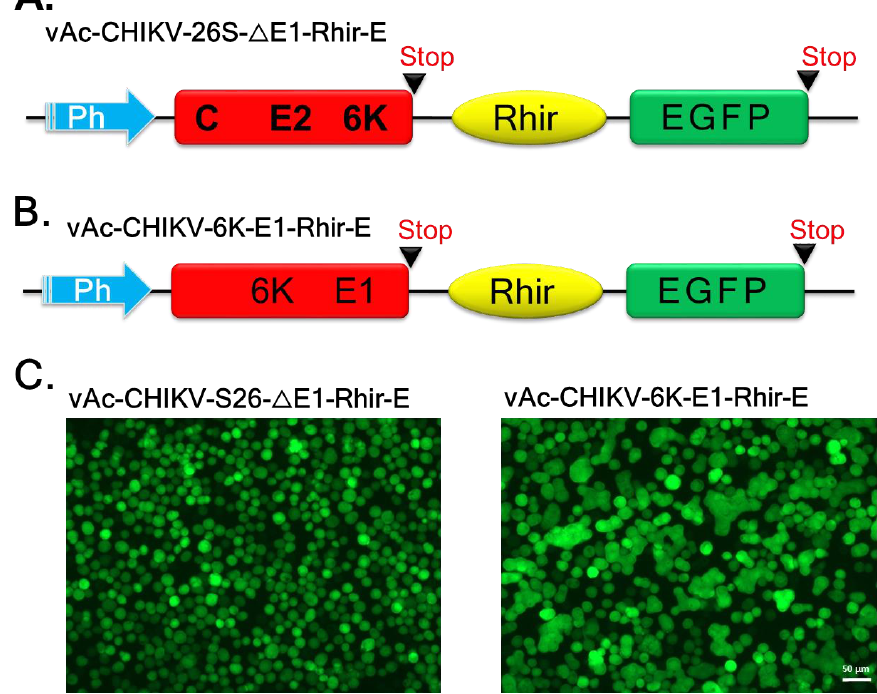
Figure 2. The E1, but not E2, of CHIKV mediated the cell fusion events in insect Sf21 cells. ( A ) vAc-CHIKV-S26- ∆ E1-Rhir-E, the recombinant baculovirus carrying the truncated CHIKV 26S in which the E1 carboxyl terminal with 89 amino acids were deleted. ( B ) vAc-CHIKV-6K-E1-Rhir-E, in which the recombinant baculovirus carrying 6K-E1 gene cDNA (a 1.8-kb DNA fragment. ( C ) Sf21 cells (2 × 10 5 cells per well seeded in a 24-well plate) were infected with the indicated viruses at a MOI of 5 and observed at 3 dpi under fluorescence microscopy. Cell fusion was observed under a fluorescence microscope with an FITC channel (green). Both pictures were taken at an exposure time of 260 ms. Bar represents 50 um. Ph, polyhedrin promoter; EGFP, enhanced green fluorescent protein gene; Rhir, RhPV 5′ UTR IRES.